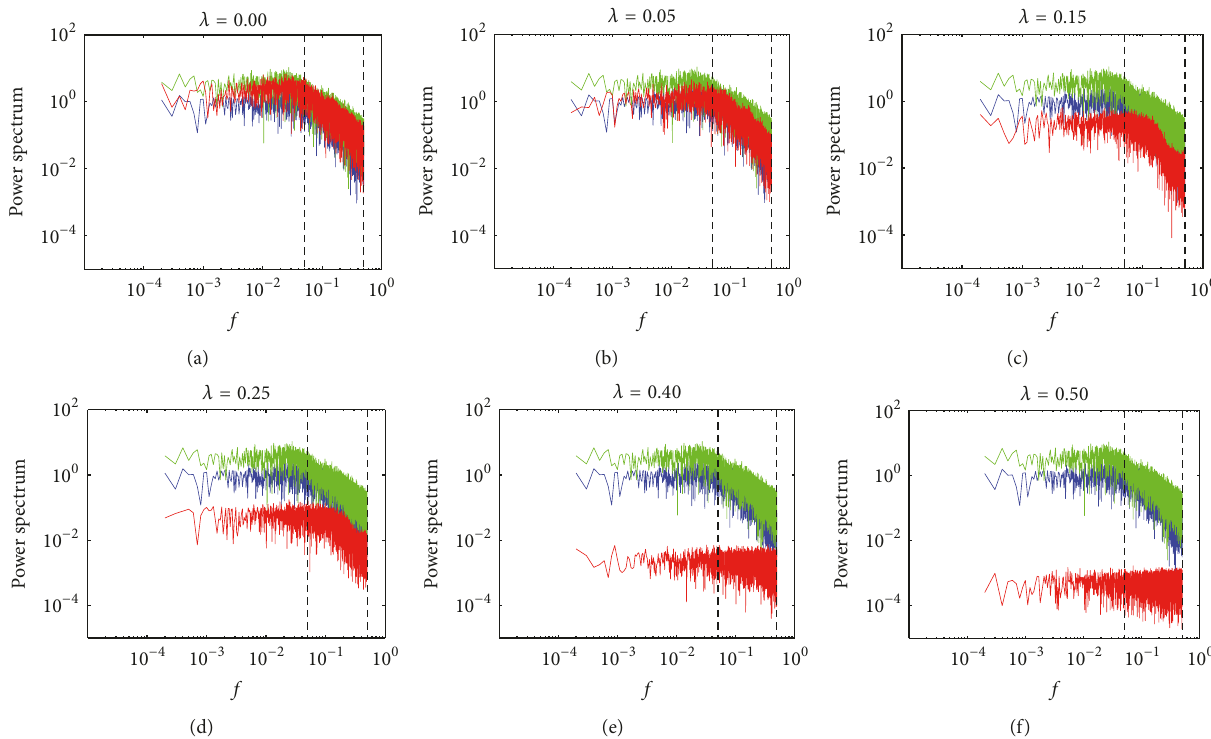
Figure 10: The power spectrum of a number of active agents obtained during a simulation for the case with 𝐿 = 0.89 is shown. The blue color corresponds to the power spectrum obtained for the Epstein model; in green color the spectrum of power corresponds to the simulation with heterogeneous saving. In red color, the power spectrum is drawn for the cases for the homogeneous saving model with 𝜆 = [0.00, 0.05, 0.15, 0.25, 0.40, 0.50 ], respectively. The region between the segmented lines shows the frequency range used to obtain the slope of the decay of the energy cascade in the inertial range.